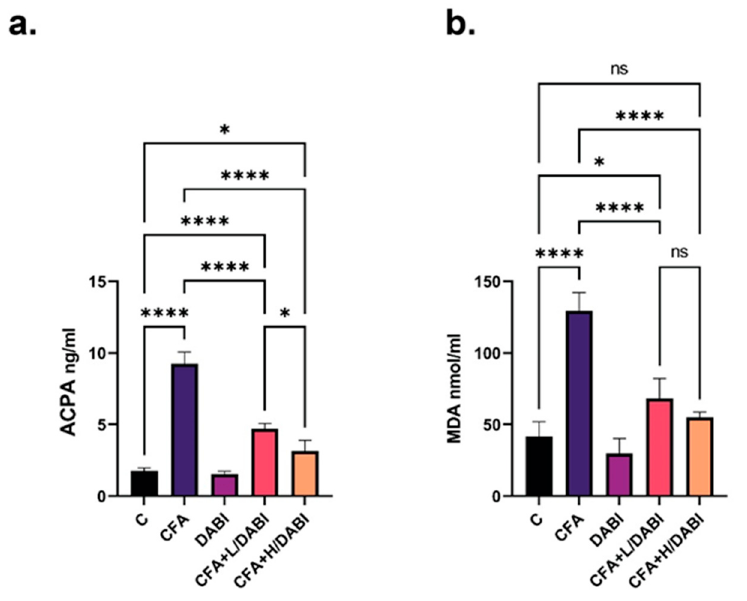
Figure 2. Effects of Dabigatran on serum ACPA and MDA levels. ELISA of serum ACPA levels ( a ), and MDA levels ( b ) in different groups as described in methods section. Not significant (ns); * p ≤ 0.05; **** p ≤ 0.0001, ( n = 8).